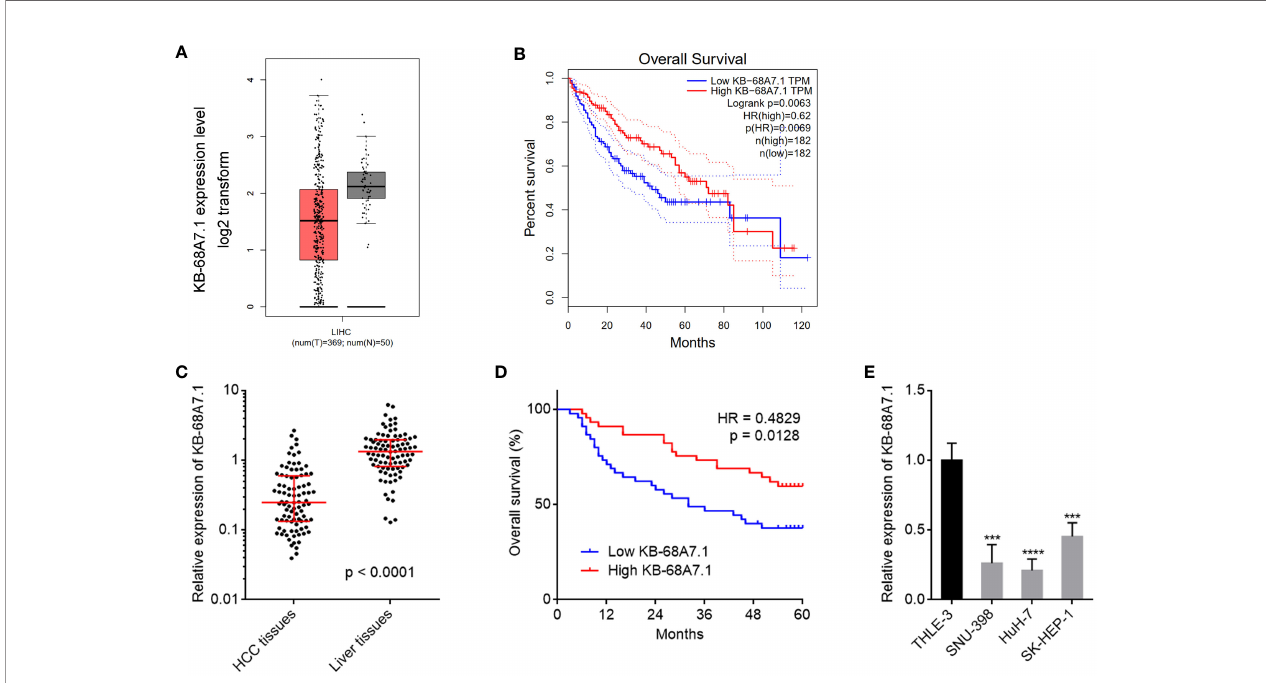
FIGURE 1 | The expression and prognostic relevance of KB-68A7.1 in HCC. (A) KB-68A7.1 expression in HCC tissues and normal liver tissues from TCGA LIHC dataset was analysed by GEPIA. (B) The correlation between KB-68A7.1 expression in HCC tissues and overall survival according to TCGA LIHC dataset was analysed by GEPIA. (C) KB-68A7.1 expression in 90 pairs HCC tissues and adjacent liver tissues was measured by RT-qPCR. p < 0.0001 by Wilcoxon matched- pairs signed-rank test. (D) Kaplan – Meier survival curves of 90 HCC patients strati fi ed by KB-68A7.1 expression. Median KB-68A7.1 expression was used as cutoff. HR = 0.4829, p = 0.0128 by log-rank test. (E) KB-68A7.1 expression in immortalized liver cell line THLE-3 and HCC cell lines SNU-398, HuH-7, and SK-HEP-1 was measured by RT-qPCR. Results are shown as mean ± SD based on three independent experiments. ***p < 0.001, ****p < 0.0001 by one-way ANOVA followed by Dunnett ’ s multiple comparisons